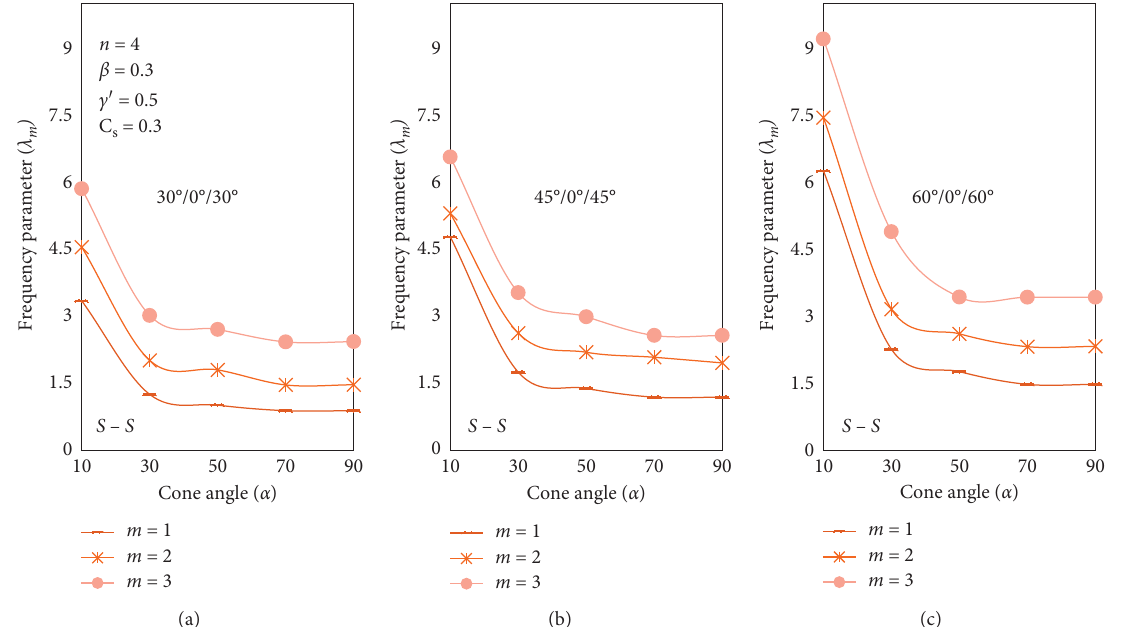
Figure 4: Influence of cone angle on the frequency parameter of three-layered conical shells with GE/EGE/GE material combination.